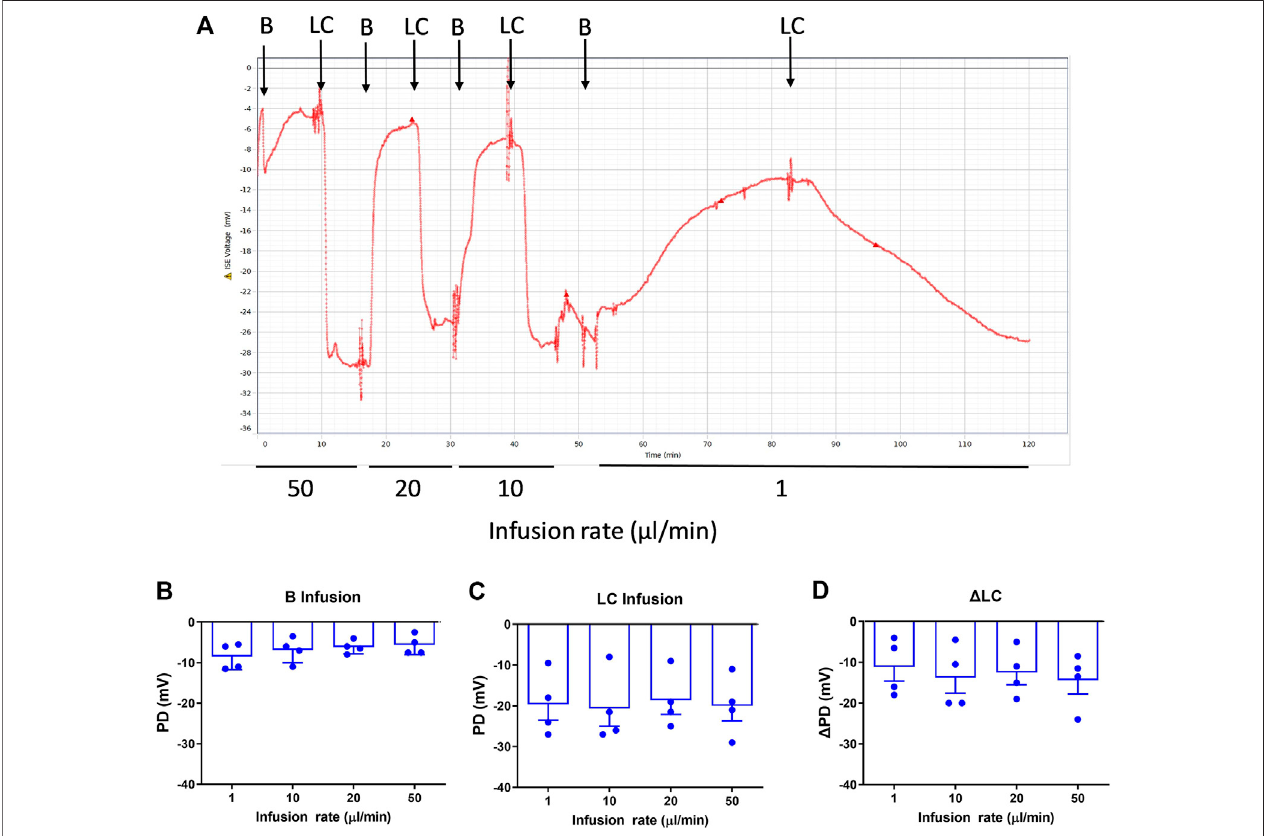
FIGURE 1 | Nasal PD measurements at different infusion rates in WT mice. (A) Typical nasal PD trace showing the reproducibility of the rapid PD method (here, alternating basal and low chloride perfusions) in the same animal. The mean response following (B) Basal (B), (C) Low chloride (LC) KRB and (D) the differencebetween LC and Basal ( Δ LC), n.s. Dunnett ’ s RM ANOVA, mean ± SEM, n (cid:2) 4.